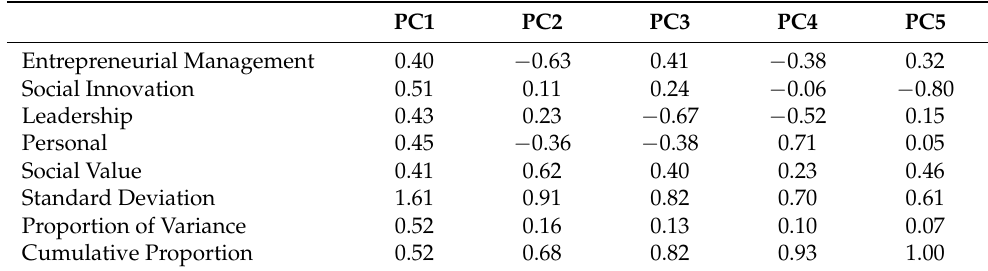
Table 4. Principal Component Matrix: Social Entrepreneurship Competency.